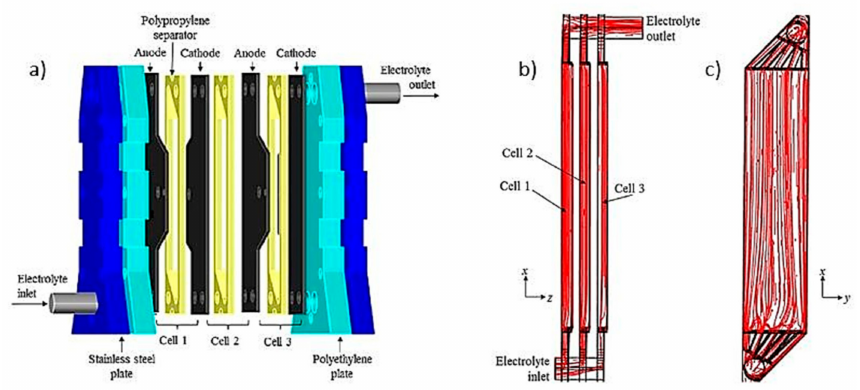
Figure 9. ( a ) Reactor FM01-LC with three cells; Streamlines ( b ) Lateral view; ( c ) back view (Adapted from Sandoval et al.